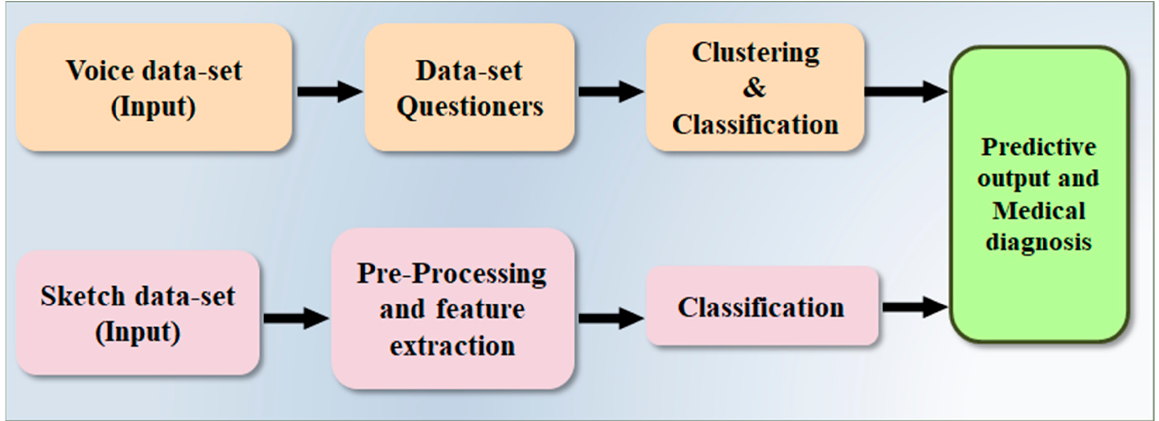
Figure 8. Proposed methodology for early detection of PD by Anitha et al. [37].